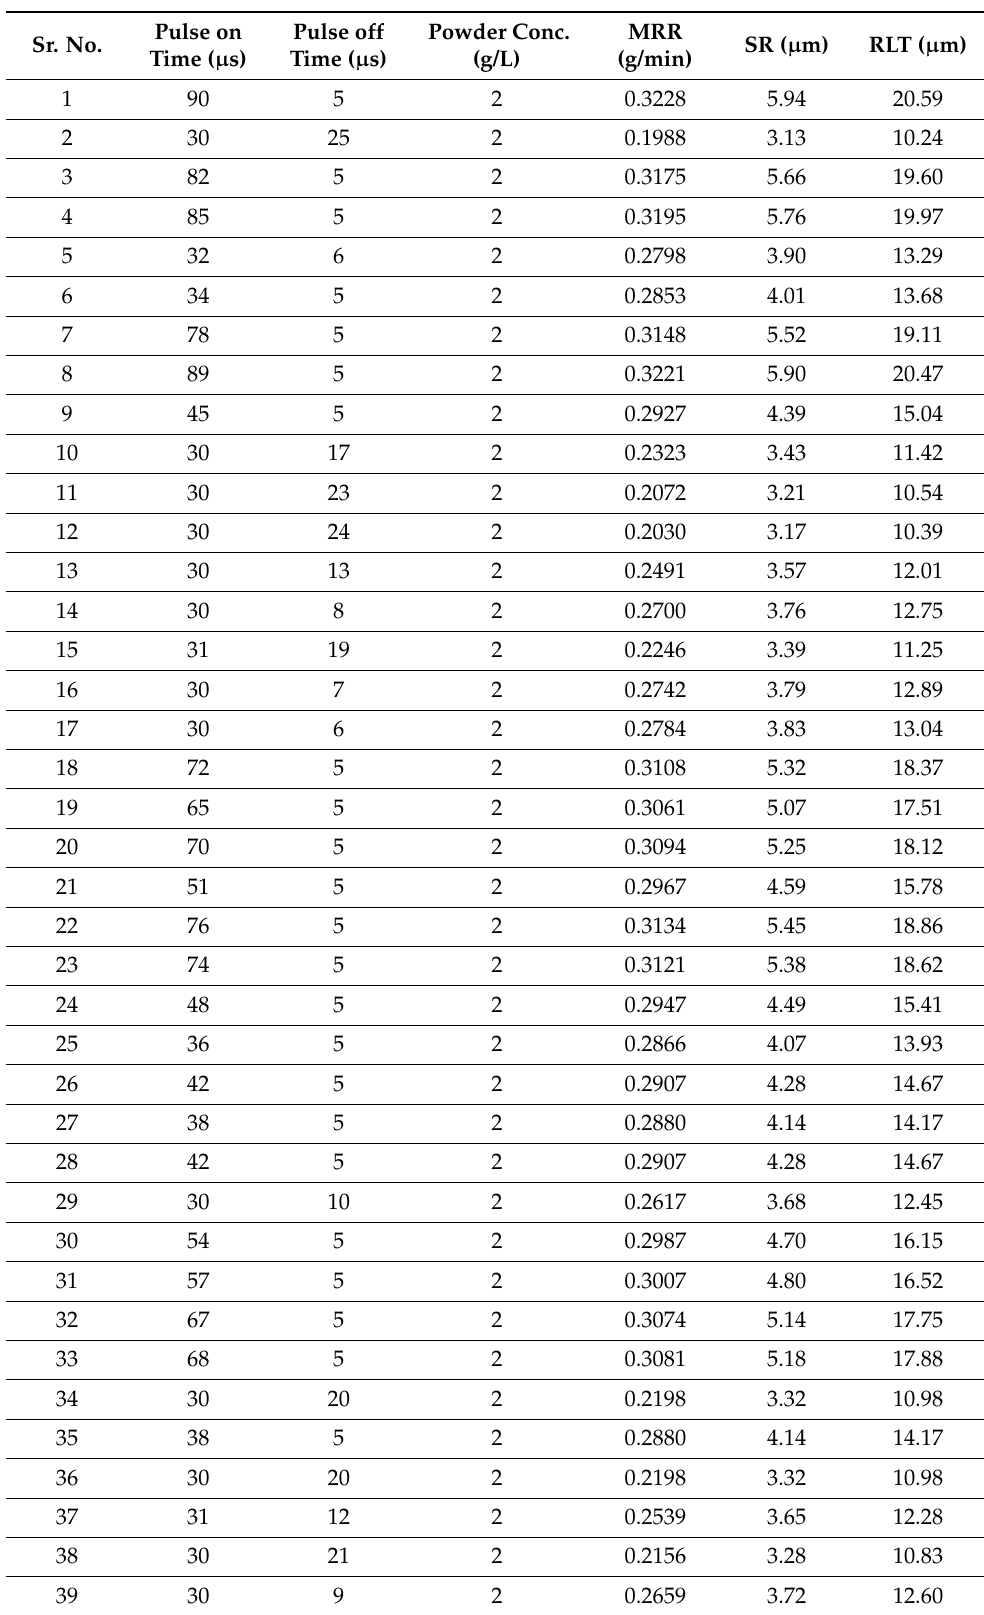
Table 7. Pareto optimal points obtained from HTS